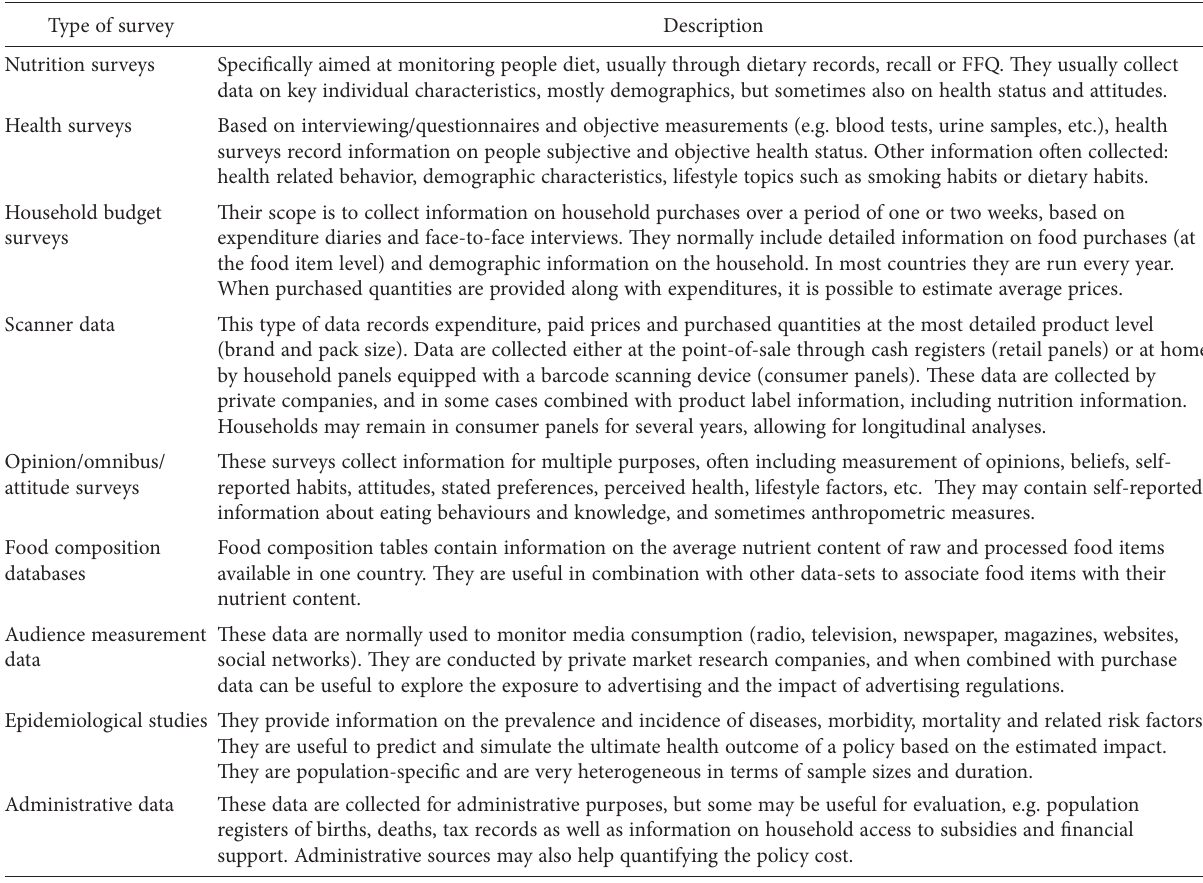
Table 3. Secondary data sources relevant for nutrition policy